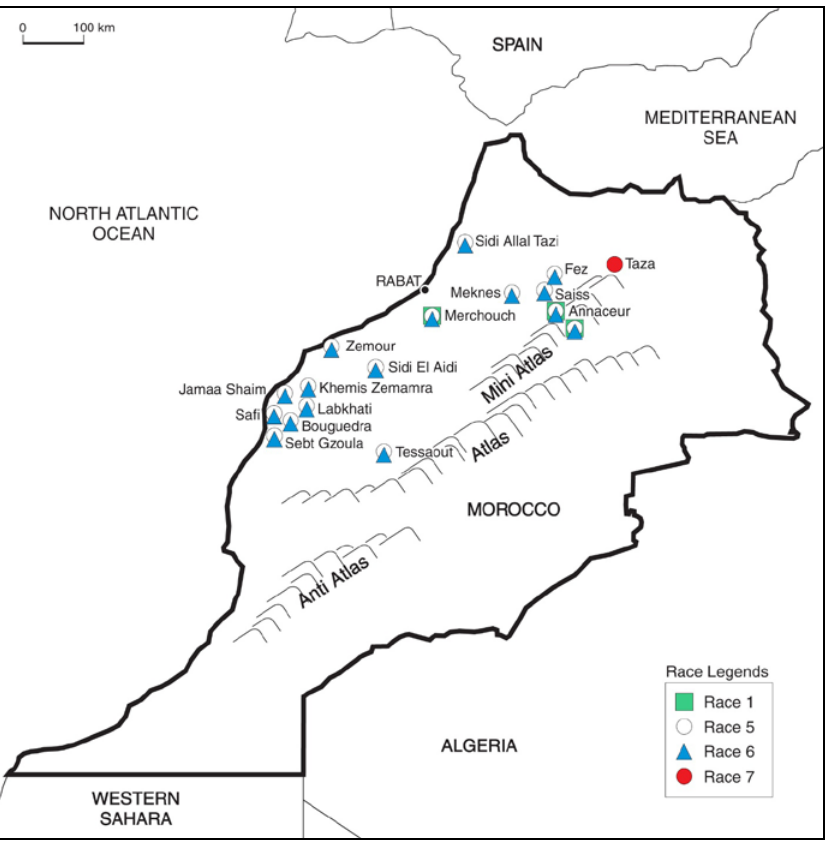
Figure 1. Map of Morocco indicating the locations sampled and the races of Pyrenophora tritici-repentis identified from 2013 to 2015 (see Table